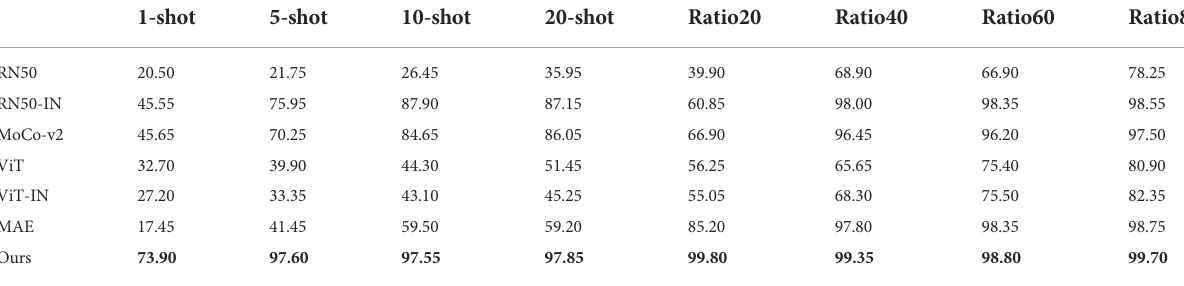
TABLE 5 The mean testing accuracy of different training methods over Strawberry2021 and